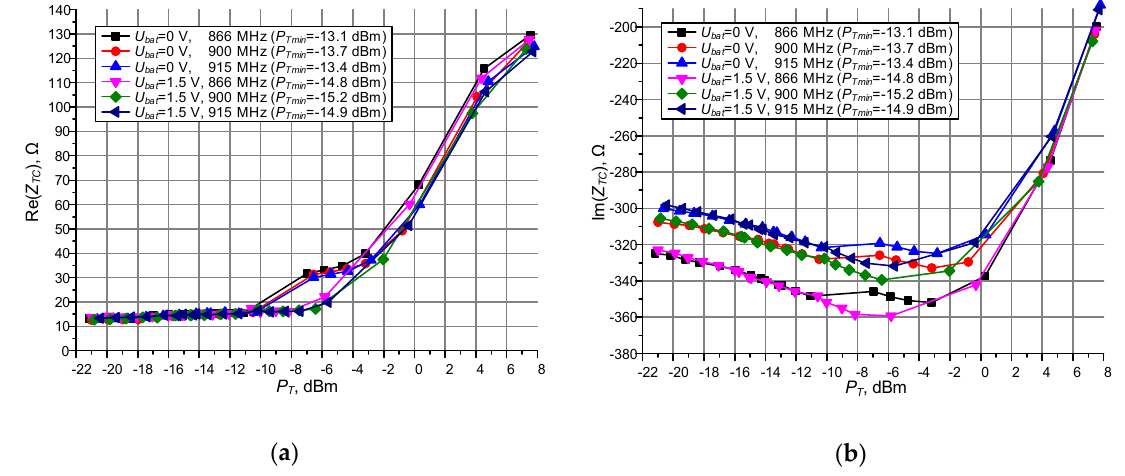
21 of 46 Figure 14. Methods of chip parameter determination: ( a ) Means by using RWD; ( b ) Means by using signal generator. SA—signal analyzer; VNA—vector network analyzer; AWG—arbitrary wave generator; VSG—vector signal generator; CIR—circulator. The main difference between the developed methods results from the way of simulating the real communication link. In the case of using a long range read/write device (with the possibility of interfering in the communications protocol and adjusting level of the output power P RWD ), application conditions of given RFID system can be reflected precisely (Figure 14a). Such a setup of the laboratory bench is particularly useful when development studies are conducted according to a real implementation of the automatic identification. It allows to test the settings of the target communication path (e.g., RWD device output power P RWD ) or the impact of environmental